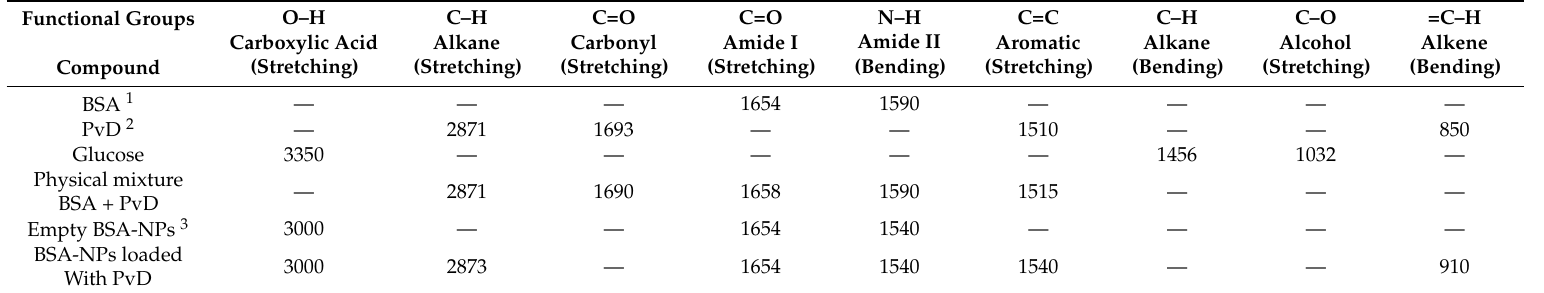
Table 2. FT-IR analysis of spectra of all tested samples (cm − 1 ).